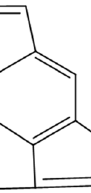
Table 3. LDI-TOF/MS identification results concerning the chemical composition of the spent catalyst. Degree of.